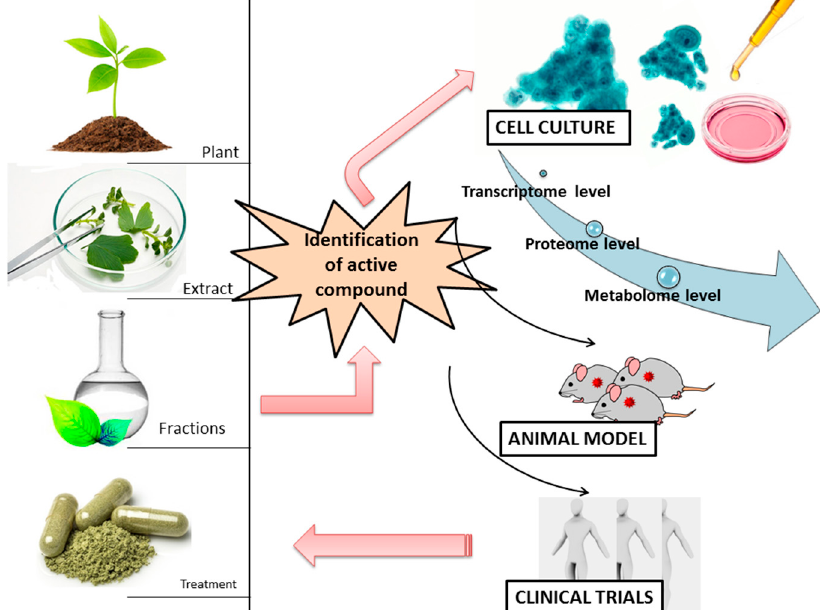
Figure 2. The summary of the workflow in the identification of the novel bioactive agent is extraction, fractionation, then cell culture based test to evaluate the effects at cellular and molecular level of the bioactive extract and validation on animal models of the most relevant finding and the final step of a novel treatment is the clinical trials evaluation.